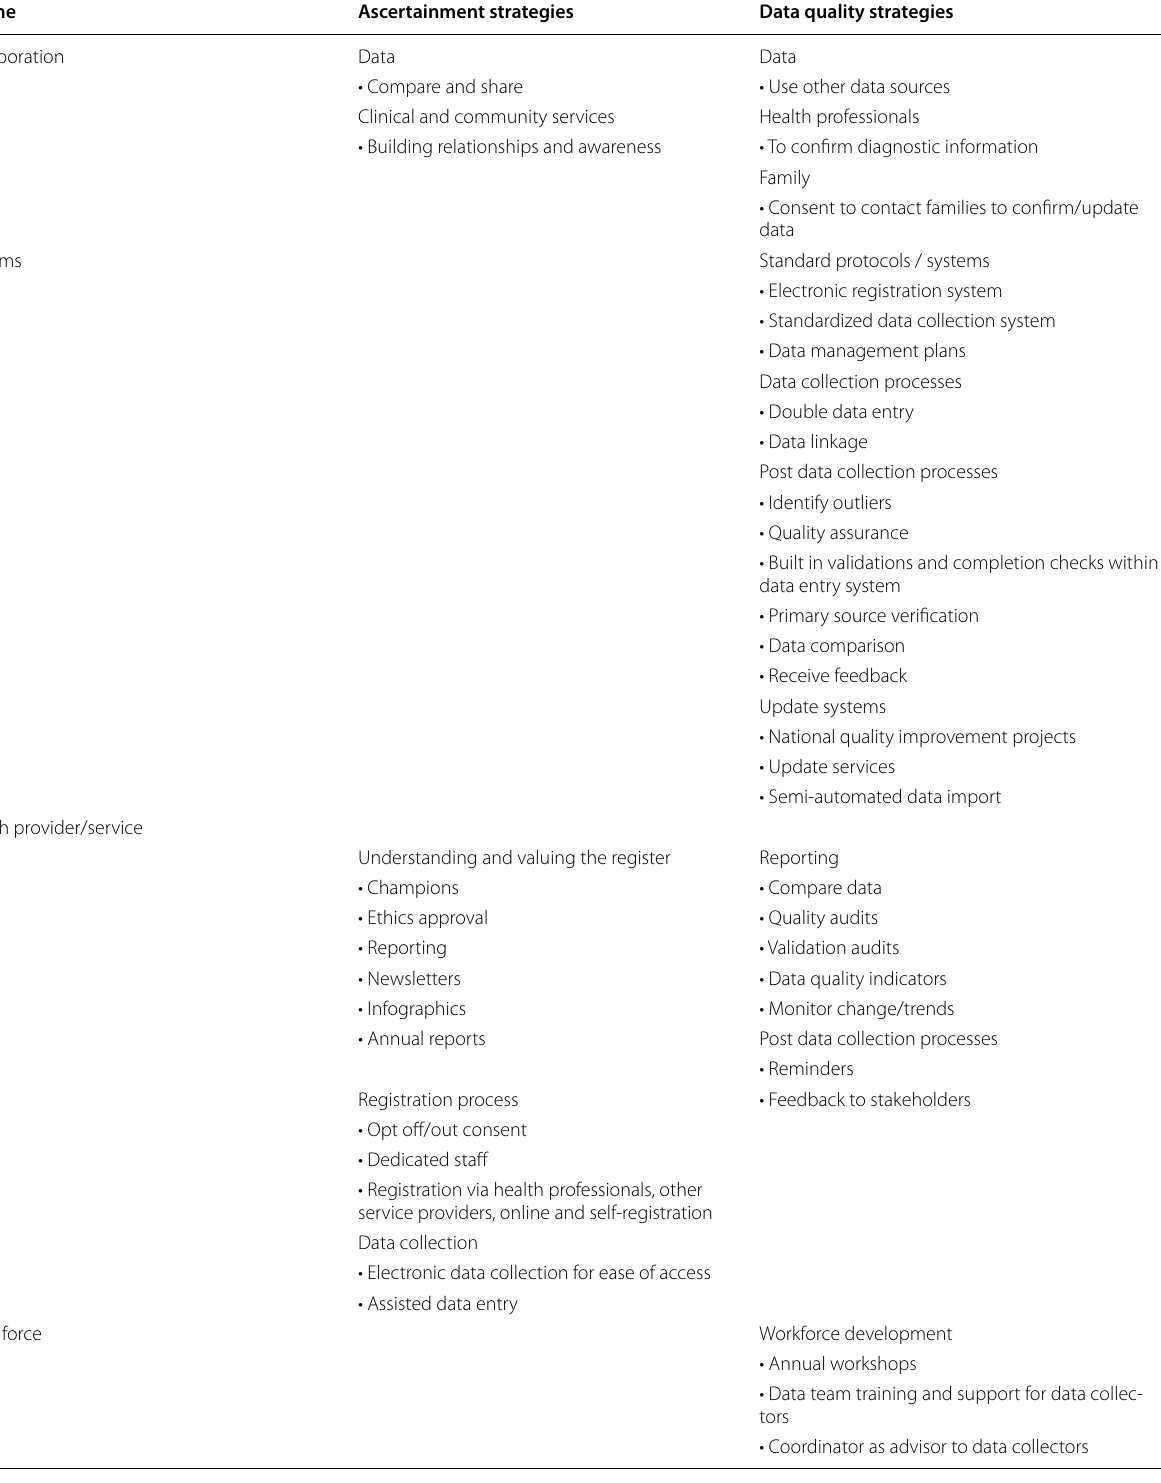
Table 3 Summary table of themes from survey respondents’ strategies to ascertain and support data quality of the target population. Blank spaces indicate no reported strategies